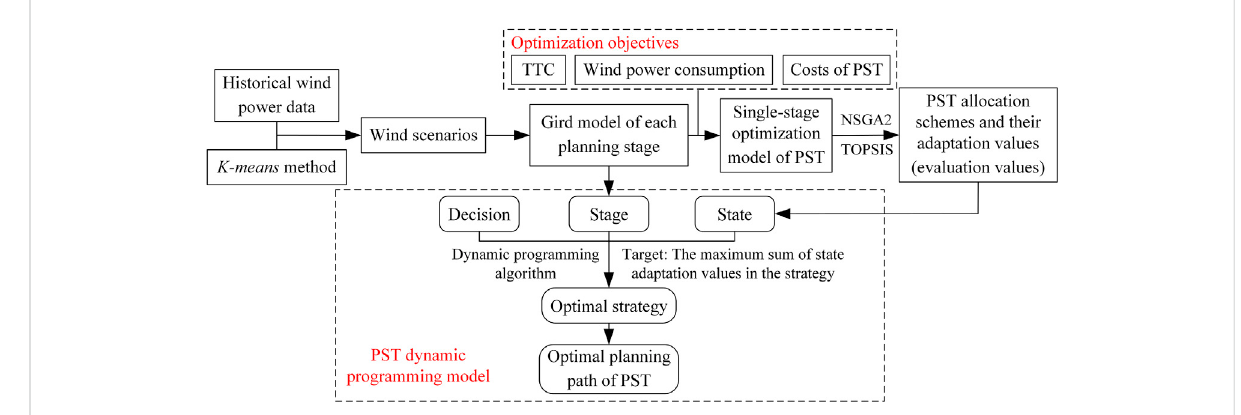
FIGURE 1 The framework of the PST allocation method.